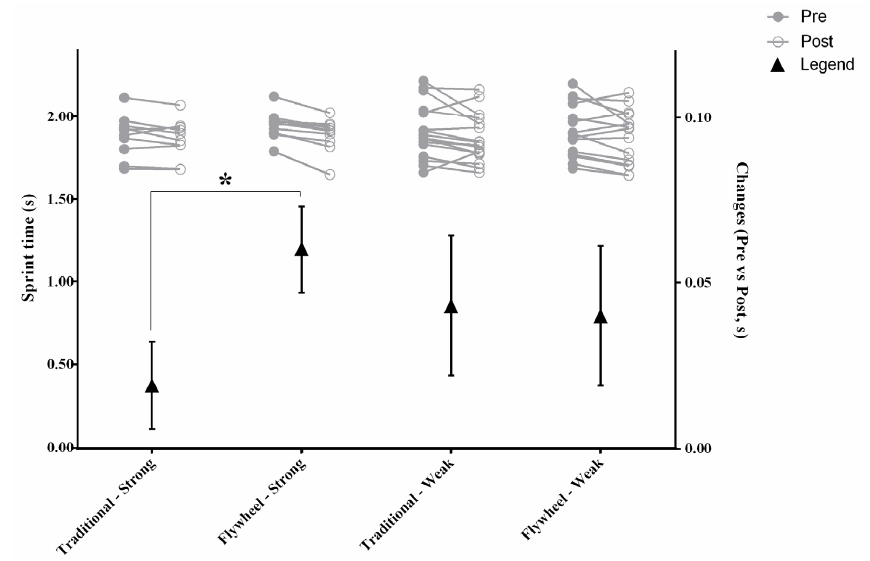
Figure 2. Group condition and individual trend changes from pre to post in sprint. Grey lines represent individual trend changes. Triangle marker represents mean ± standard error group changes. * = significant time*condition interaction ( p < 0.005).